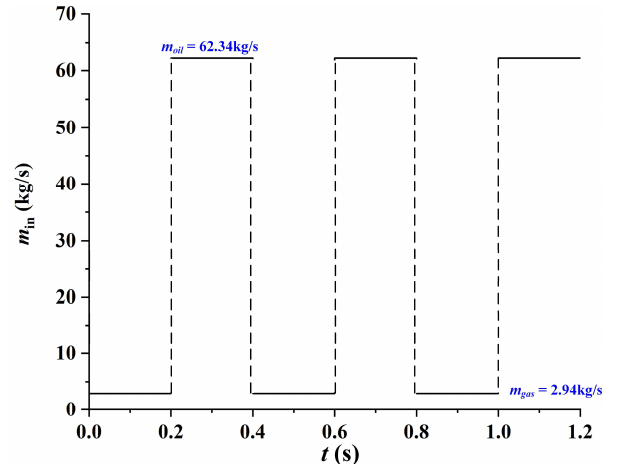
Figure 5. The variation of mass flow rate ( m in ) monitored in the inlet, taking case 1 as an example, where m oil and m gas are the mass flow rate of oil and gas, respectively.